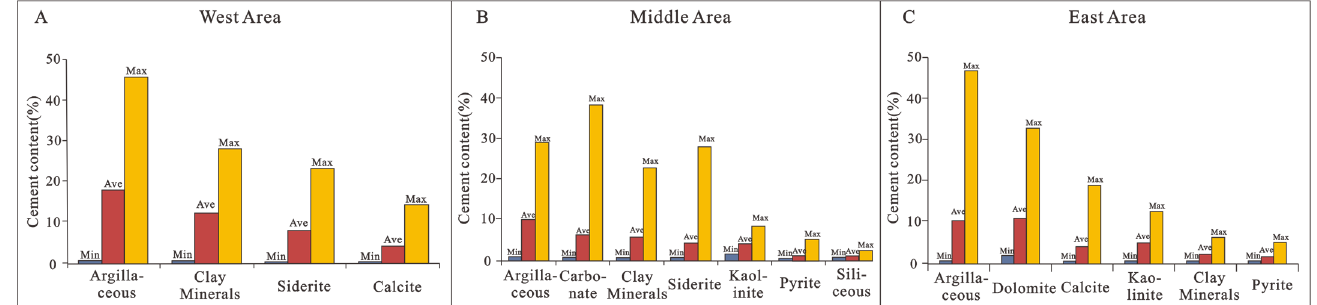
Figure 7. The cement types and contents of west area ( A ), Middle area ( B ) and East area ( C ) of the Liushagang Formation in the northern steep-slope zone of the Weixinan Sag. The middle area is moderately buried and moderately compacted, and the detrital grains are the line contact (Figure 6B); the interstitial materials are cemented by argilla- ceous, carbonate, and clay minerals (Figures 6F and 7B), and the primary and secondary pores are developed. The late organic acid dissolution is primary, and the dissolution pores are medium (Figure 6H).